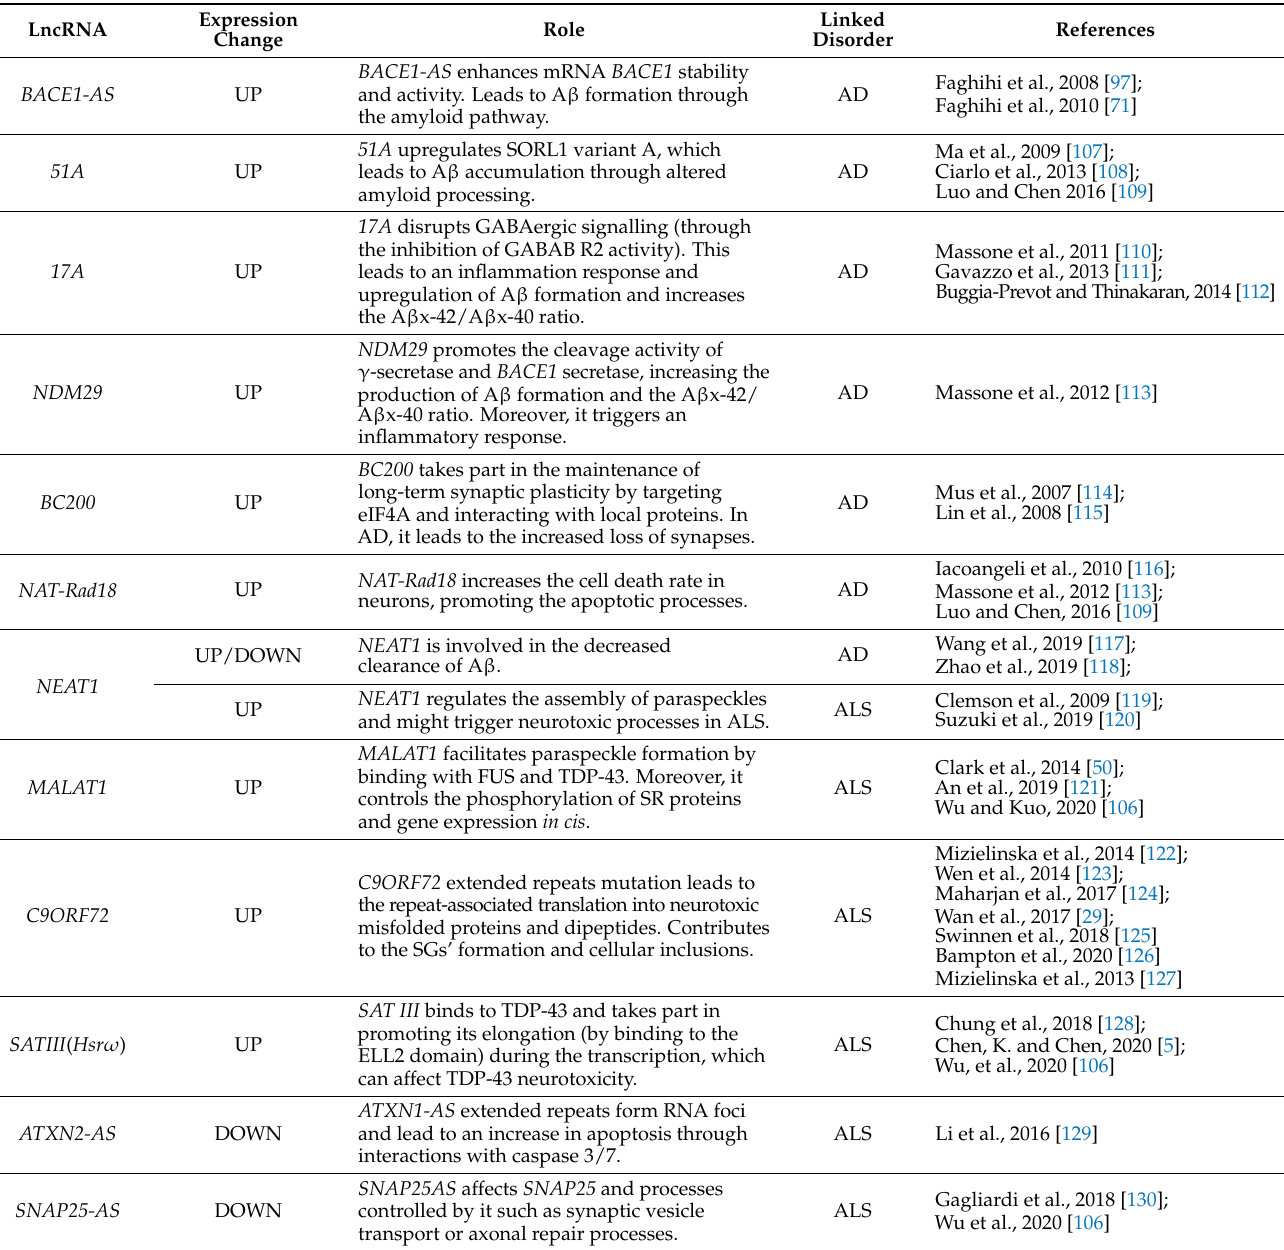
Table 1. LncRNAs dysregulated in neurodegenerative disorders. The chosen examples of lncRNAs involved in neurodegen- erative disorders. (UP: upregulation; DOWN: downregulation; references are also